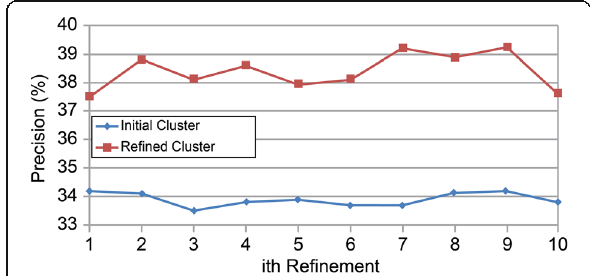
Fig. 6 Precision of the initial cluster and that of the refined cluster after running Tabu Search ten times